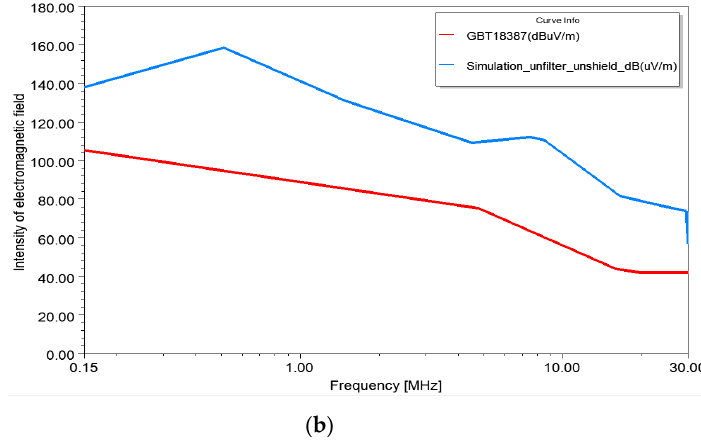
Figure 9. ( a ) Distribution of electromagnetic field; ( b ) electric field intensity at 3 m. 4.3.2. Radiated Emission of EV Using a π-Type Filter The common-mode current on the HVDC cable with a π-type filter and the unshielded HVDC cable were imported into the vehicle for frequency domain analysis. The calculated electromagnetic field distribution and EMF emission intensity at 3 m are shown in Figure 10.